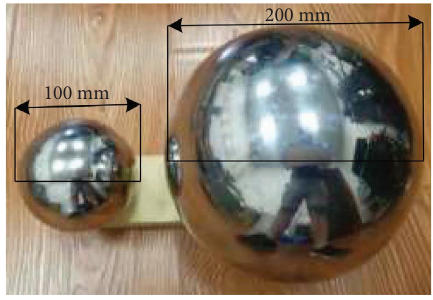
Figure 4: Te physical map of the calibration